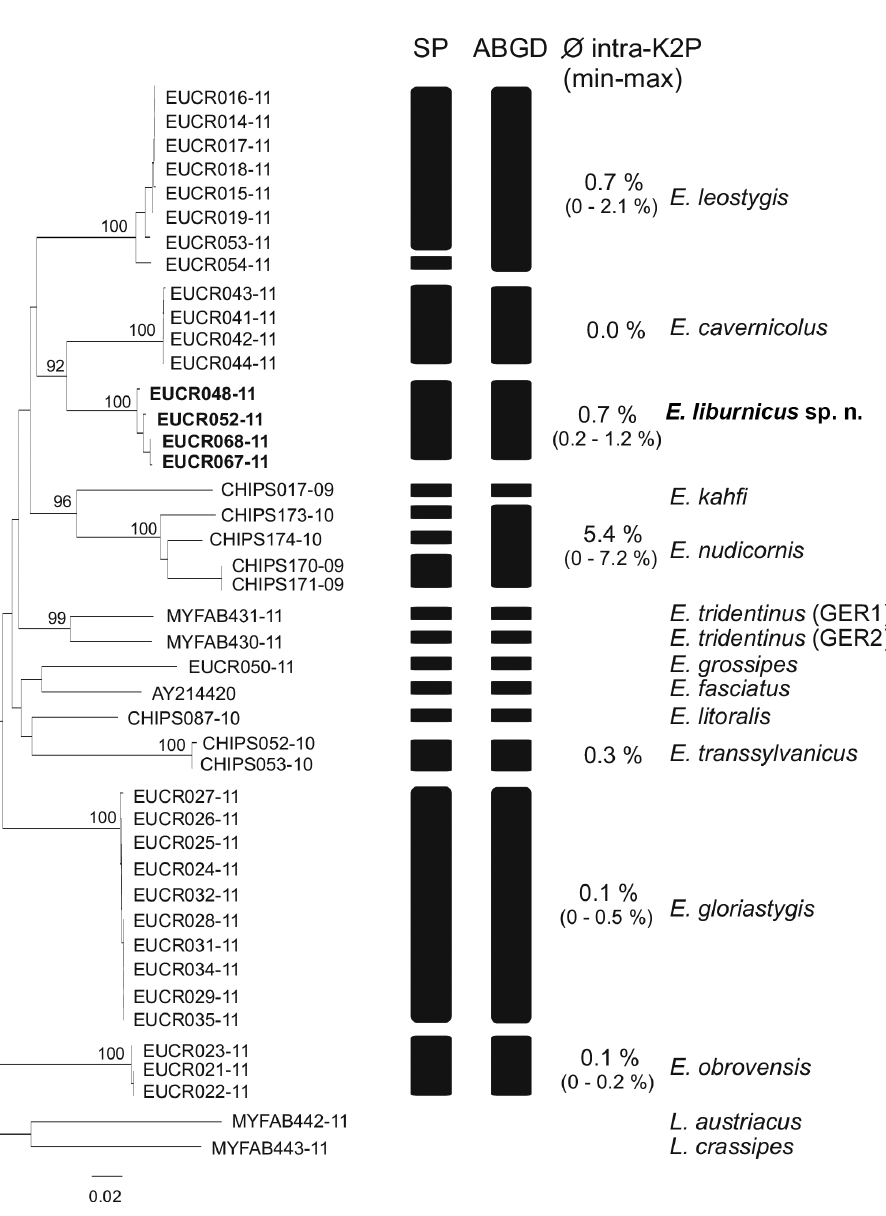
Figure 13. Molecular species delimitation. ABGD proposed 15 clusters congruent to the morphospecies